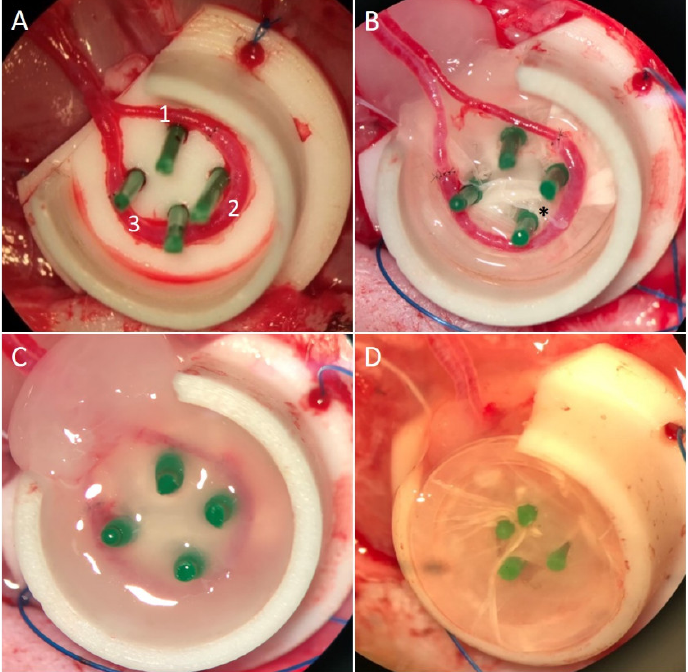
Figure 2. ( A ): EPI loop consisting of SIEA (1), vein interposition (2) and ipsilateral SIEV (3); ( B ): PTFE chamber including four spacers and two layers of nanofiber scaffolds, EPI loop with obturator nerve (*); ( C ): Fibrin gel on top of scaffolds and EPI loop; ( D ): two more layers of PCL-collagen/PCL-collagen-PEO nanofiber scaffolds on top.